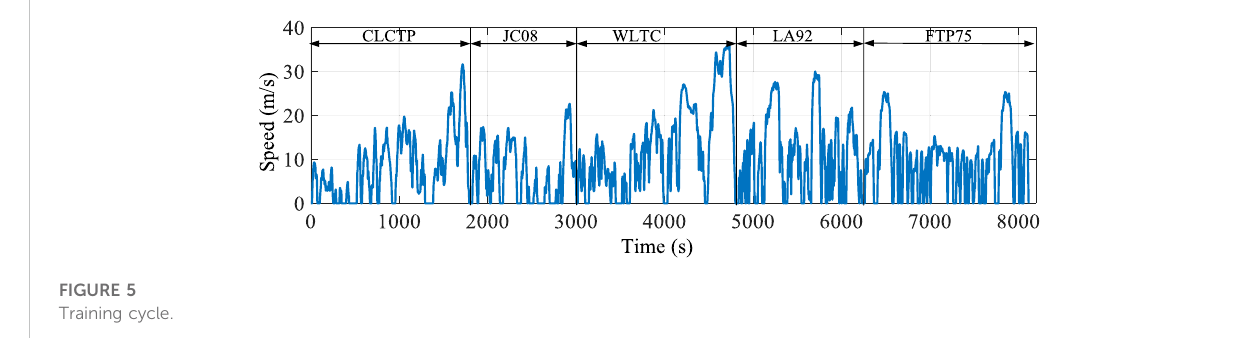
FIGURE 5 Training cycle.